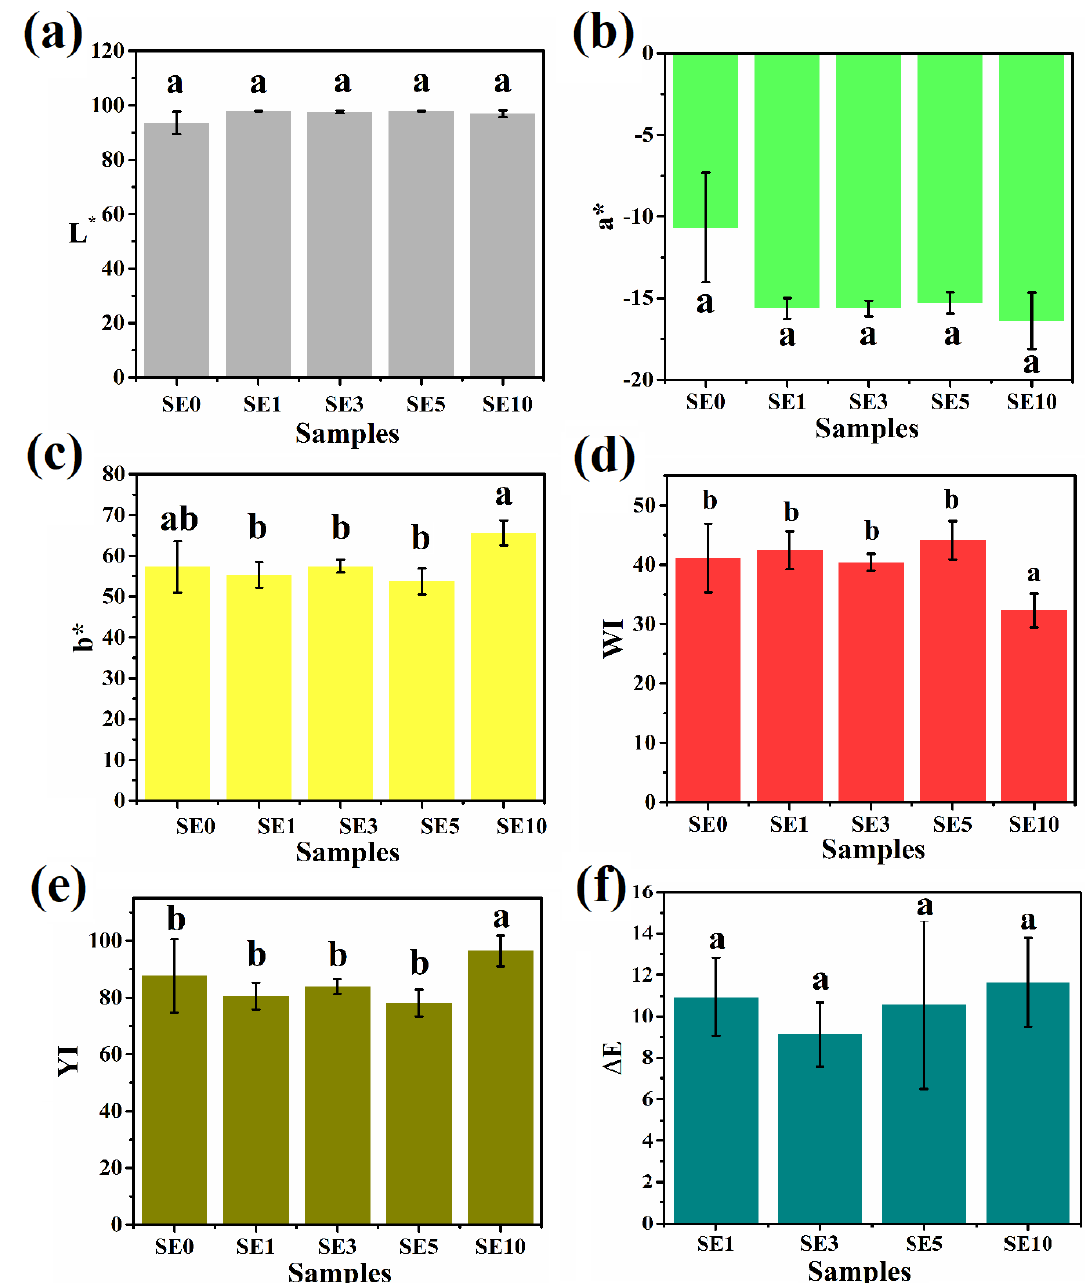
Figure 4. Color parameters: ( a ) L* values, ( b ) a* values, ( c ) b* values, ( d ) Whiteness index values, ( e ) Yellowness index values, and ( f ) ∆ E values. The values denoted in the graphs are the average ± SD of triplicate samples (Significance level, p = 0.05). Bars with different letters differ significantly ( p < 0.05).